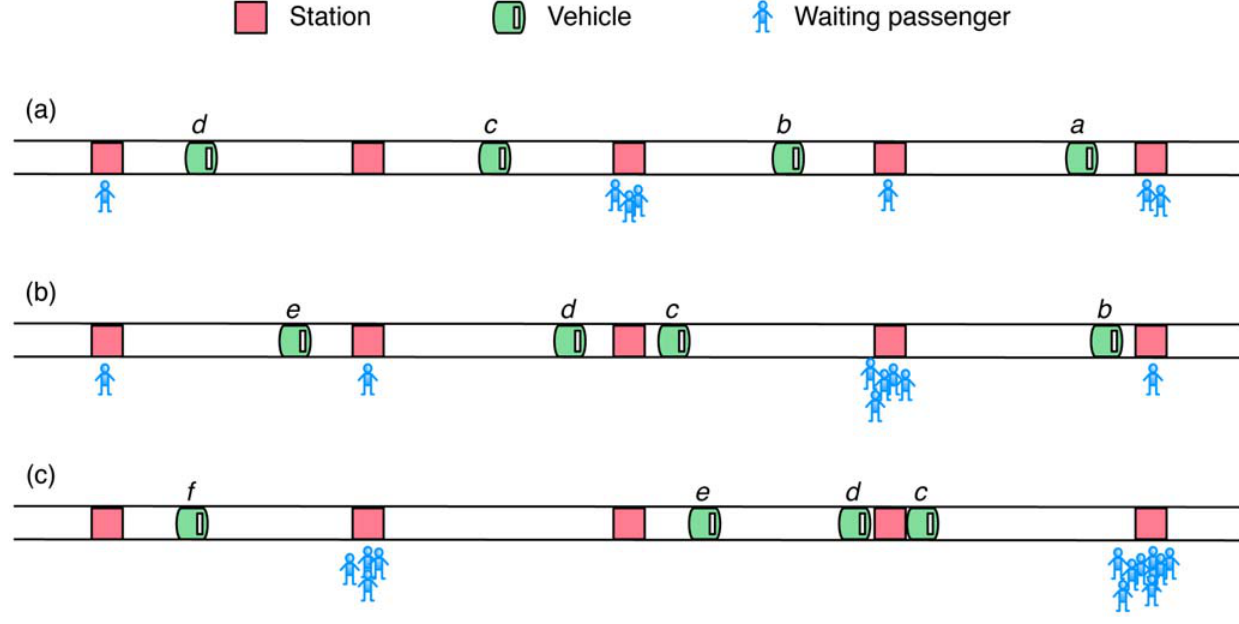
Figure 1. Illustration of equal headway instability. a) Vehicles with a homogeneous temporal distribution, i.e. equal headways. Passengers arriving at random cause some stations to have more demand than others. b) Vehicle c is delayed after serving a busy station. This causes a longer waiting time at the next station, leading to a higher demand ahead of c . Also, vehicle d faces less demand, approaching c . c) Vehicle c is delayed even more and vehicles d and e aggregate behind it, forming a platoon. There is a separation between e and f , making it likely that f will encounter busy stations ahead of it. This configuration causes longer waiting times for passengers at stations, higher demands at each stop, and increased vehicle travel times. The average service frequency at stations is much slower for platoons than for vehicles with an equal